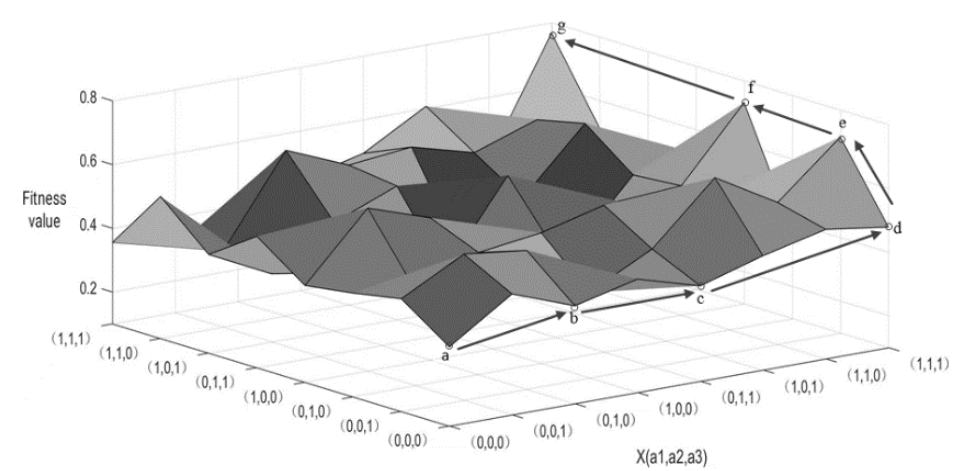
Figure 5. Fitness landscape of the ecological niche of photovoltaic agriculture. Each vertex in Figure 5 represents a different combination of the niche states of photovoltaic agriculture. The arrows in the landscape indicate the evolution path of pho- tovoltaic agriculture from lower niche fitness combination to higher niche fitness combi-